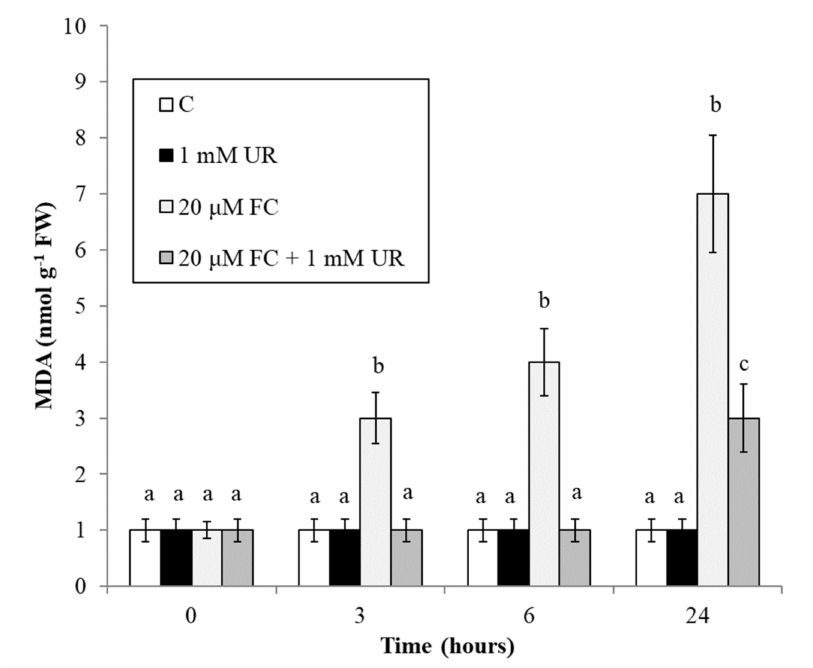
Figure 5. Effect of FC and urate on MDA accumulation. Means ± SD (n ≥ 9) are shown. Different letters show significant differences among treatments at each time (Tukey HSD test, p ≤ 0.05).